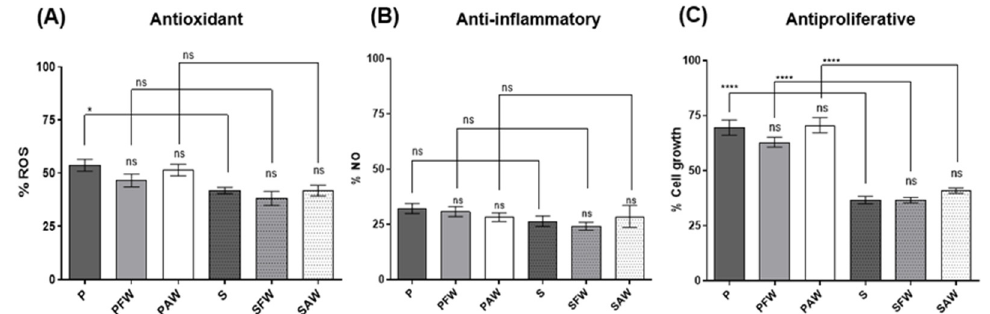
Figure 2. Cellular antioxidant, anti-inflammatory, and antiproliferative activities assessed through the determination of intracellular reactive oxygen species (ROS) levels in beer samples vs. LPS stim- ulated control ( A ); the determination of extracellular NO levels in cells exposed to beer vs. LPS con- trol ( B ); and cell viability measured after exposure of cells to 20% sample (beer in CM) vs. medium control after 48 h exposure ( C ). ns: not significant. **** Significant at p < 0.001. * Significant at p < 0.05.